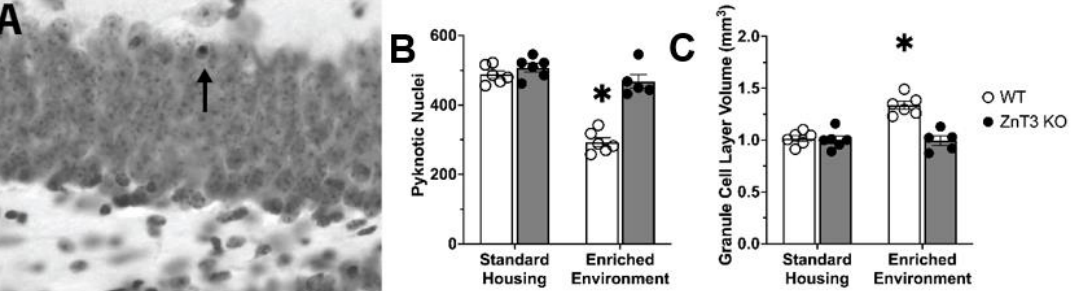
Figure 3. Cell death and granule cell layer volume in WT and ZnT3 KO mice exposed to SH or EE ( n = 23). ( A ) A representative photomicrograph of cresyl violet-stained sections of the granule cell layer reveals pyknotic nuclei that are characteristic of dying cells (arrow). ( B ) The level of cell death did not differ between WT and ZnT3 KO mice in SH. EE significantly decreased cell death in WT mice but had no effect in ZnT3 KO mice. ( C ) There were no differences in granule cell layer volume between WT and ZnT3 KO mice in the SH condition. Granule cell layer volume is significantly in- creased in WT but not in ZnT3 KO mice exposed to EE. Error bars represent ± standard error of the mean. * indicates p < 0.001.